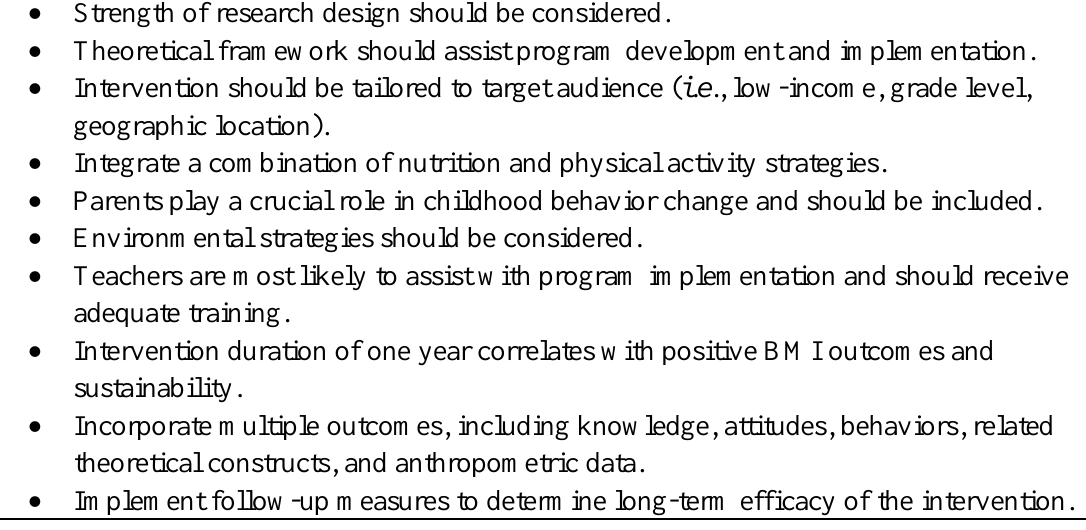
Table 3. Recommendations for school-based obesity prevention